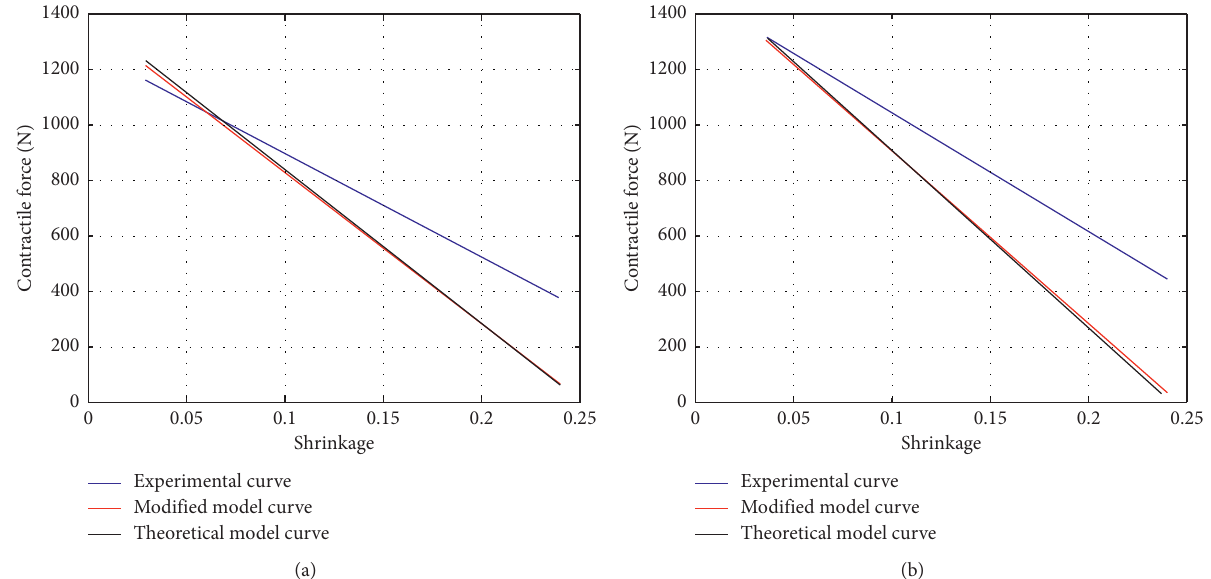
Figure 8: The comparison between mathematical model and experimental data with the PAM shrinking and stretching of p � 0 . 5MPa.